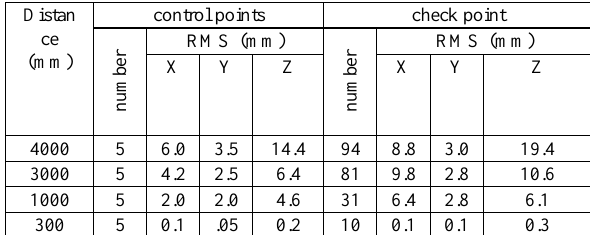
Table 1 Main parameters of the camera